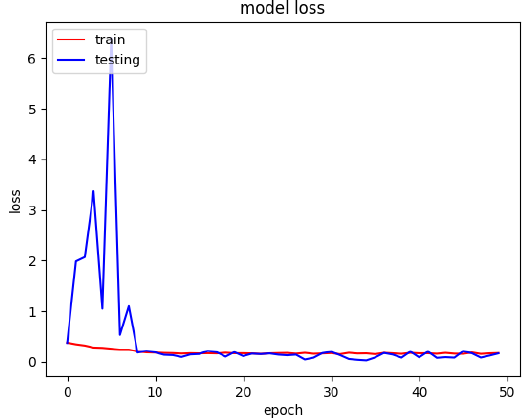
Figure 7. COVID-19 CXR Model Loss Graph.